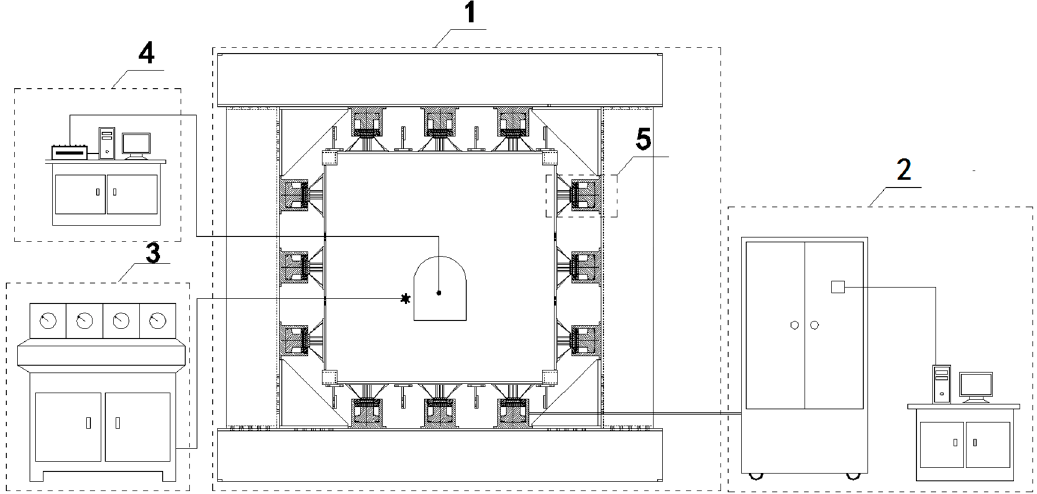
Figure 1. Plane design diagram of the overall model test system. 1: Combined bench counterforce device; 2: intelligent hydraulic loading / unloading control system; 3: automatic model displacement test system; 4: high-definition multi-probe peeping system; and 5: ultrahigh-pressure true triaxial non-uniform loading / unloading device.